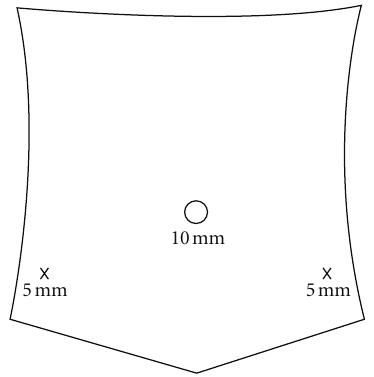
Figure 4: A high-power photomicrograph shows an endothelial- lined thin lymphatic, and thicker vascular channels with areas of lymphoid